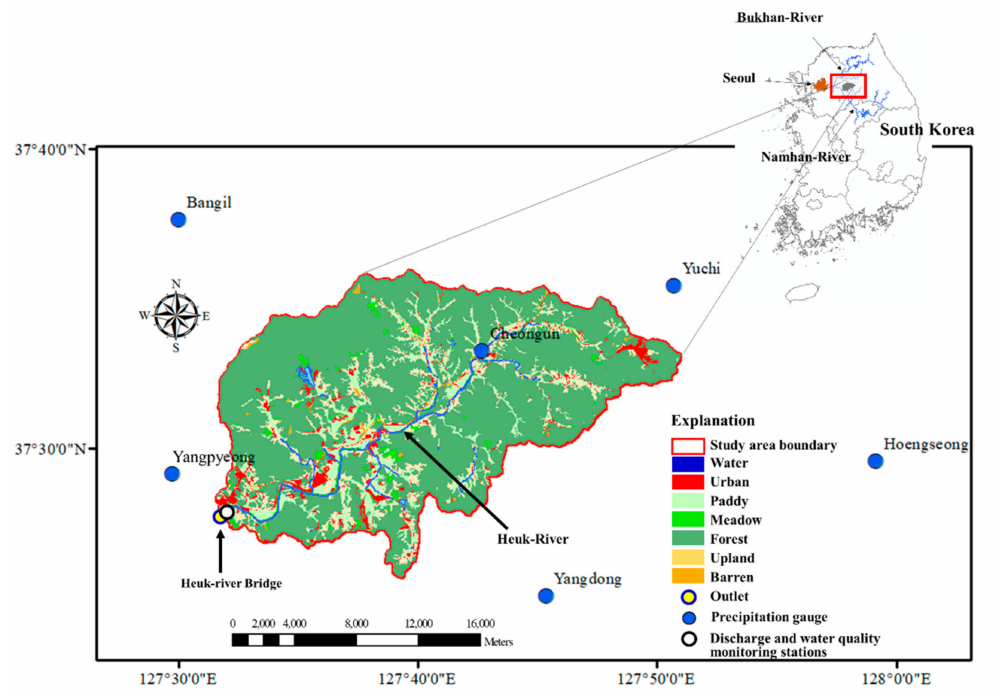
Figure 1. Schematic of study